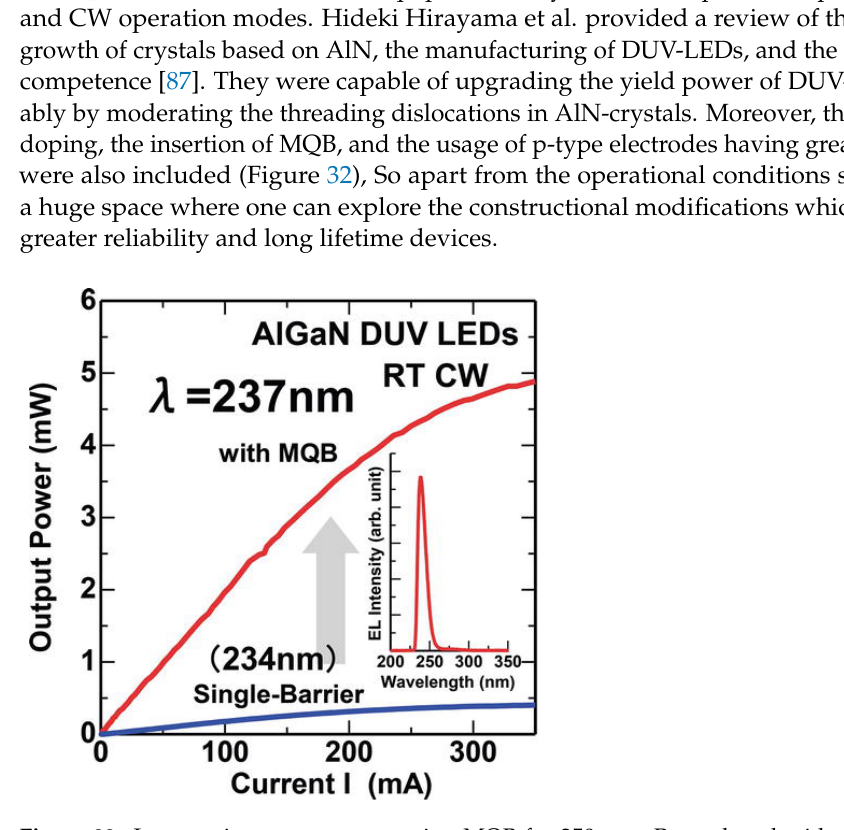
Figure 32. Increase in output power using MQB for 250-nm. Reproduced with permission. [87] Cop- yright 2015, Wiley. Copyright 2015,